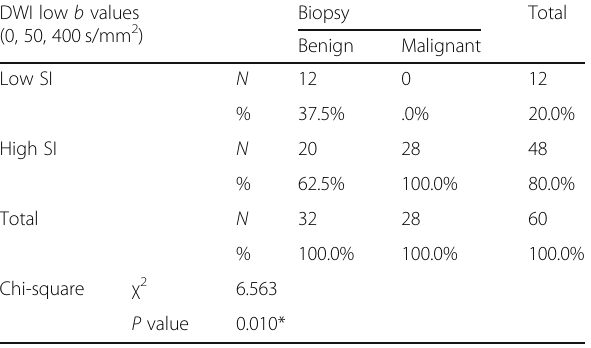
Table 2 Distribution of the studied cases according to diffusion signal intensity % from the total at low b value DWI low b values (0, 50, 400 s/mm 2 )